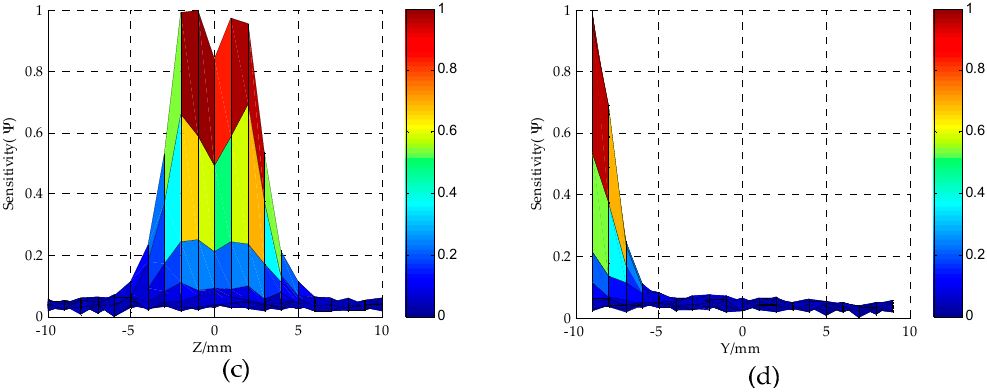
Figure 7. Sensor sensitivity distribution in YoZ plane sensitive field ( D = 20 mm, h = 2 mm, d = 1.5 mm, S = 4 mm): ( a , b ) YoZ plane regions; ( c ) Z-axis direction; ( d ) Y-axis direction.